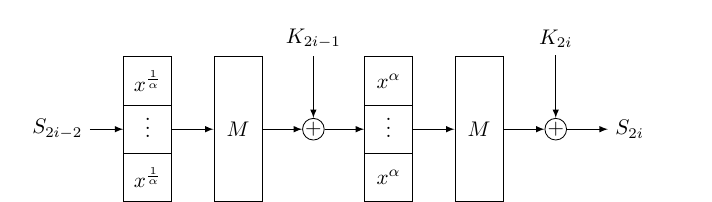
Figure 2: One round (two steps) of Rescue where the addition with the key is taken over a prime